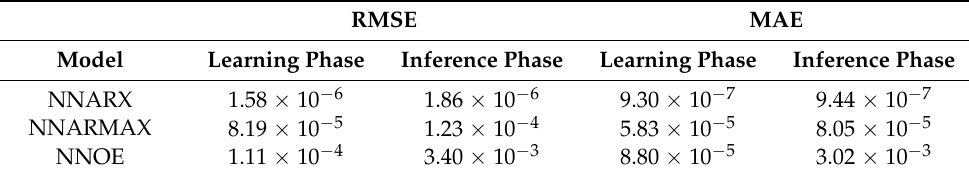
Table 3. Comparison results of prediction for various nonlinear DNN models in the learning phase and inference phase.